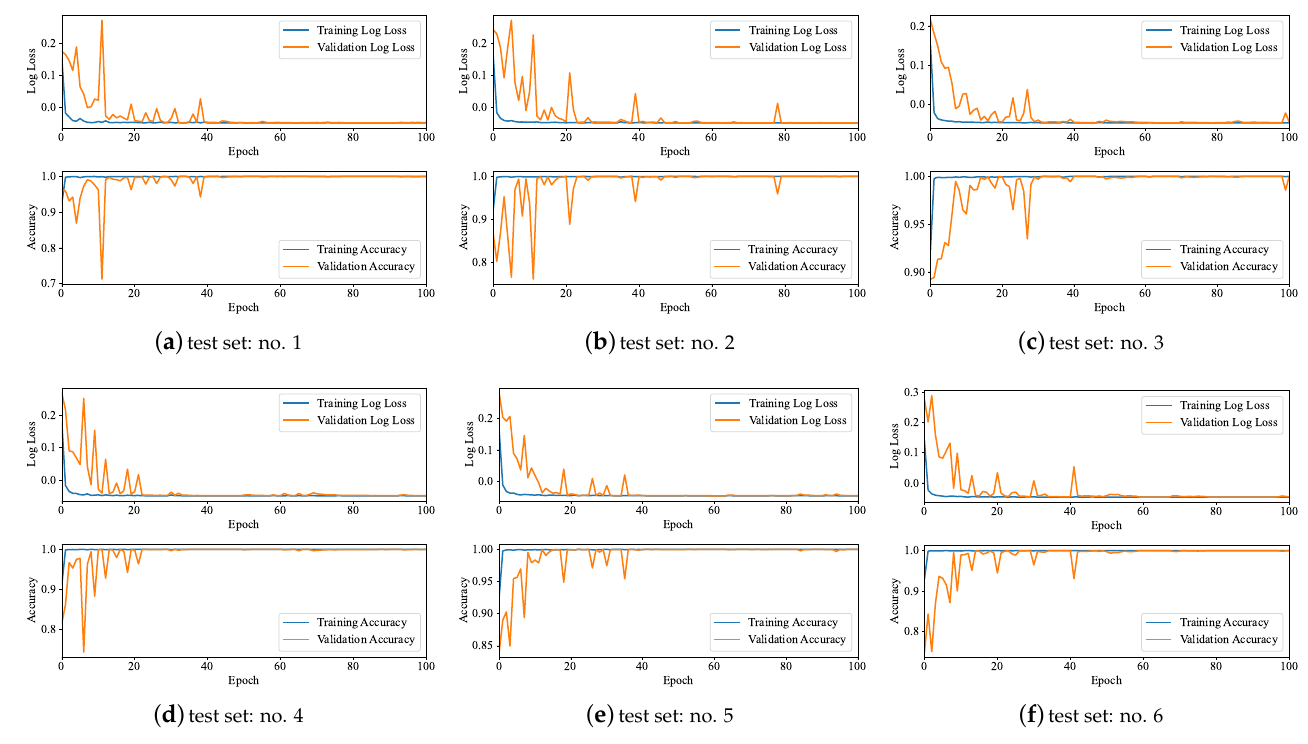
Figure 7. Training details for six folds. To facilitate the observation, only the trends of the first 100 epochs are presented, and the log scale is used on the loss.